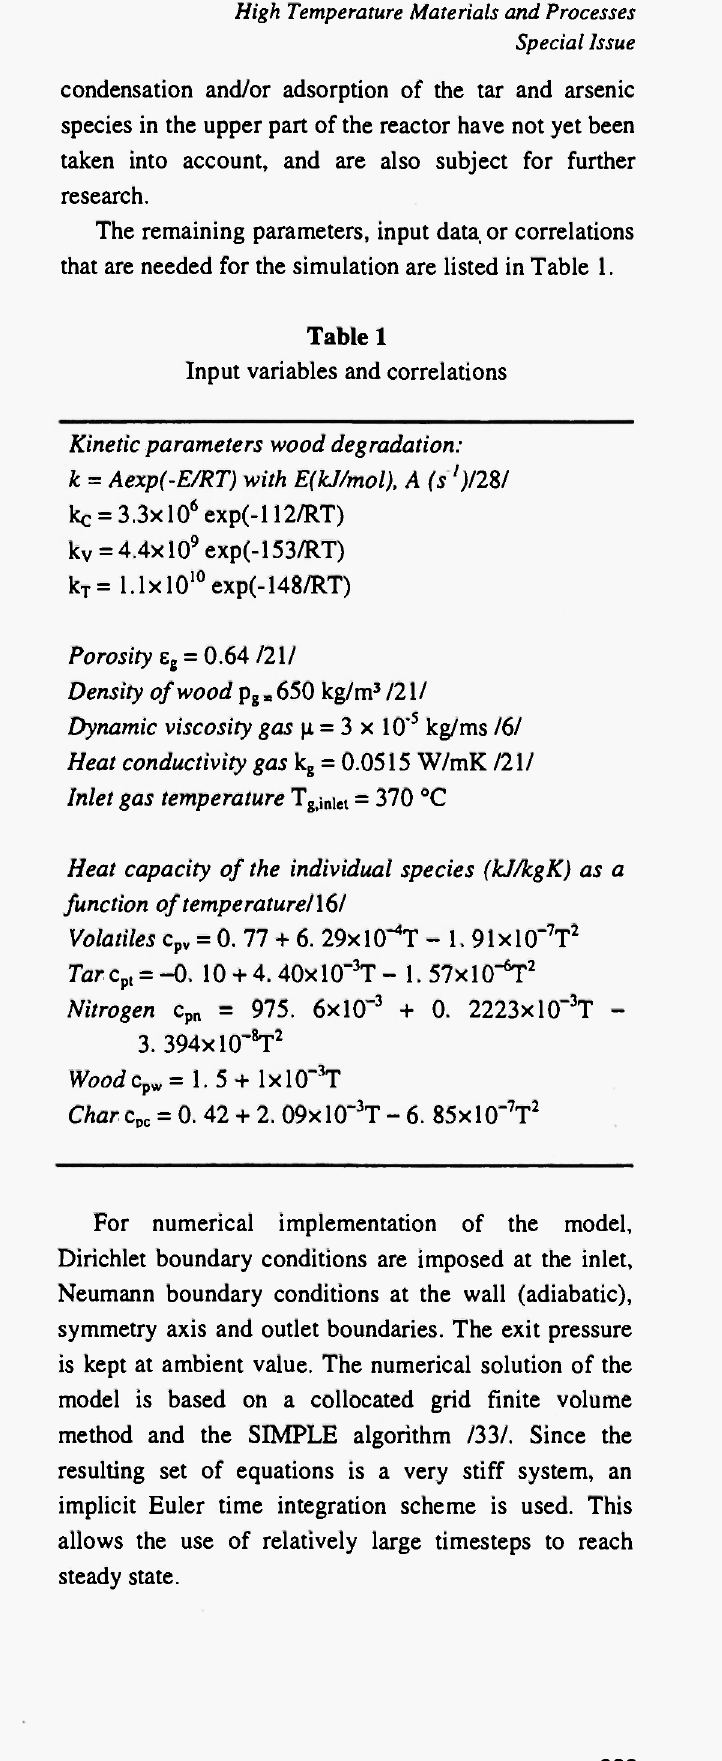
Input variables and correlations Kinetic parameters